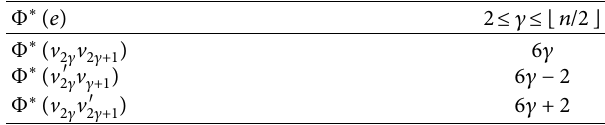
Table 34: Edge labeling of Φ ∗ ( e ) .